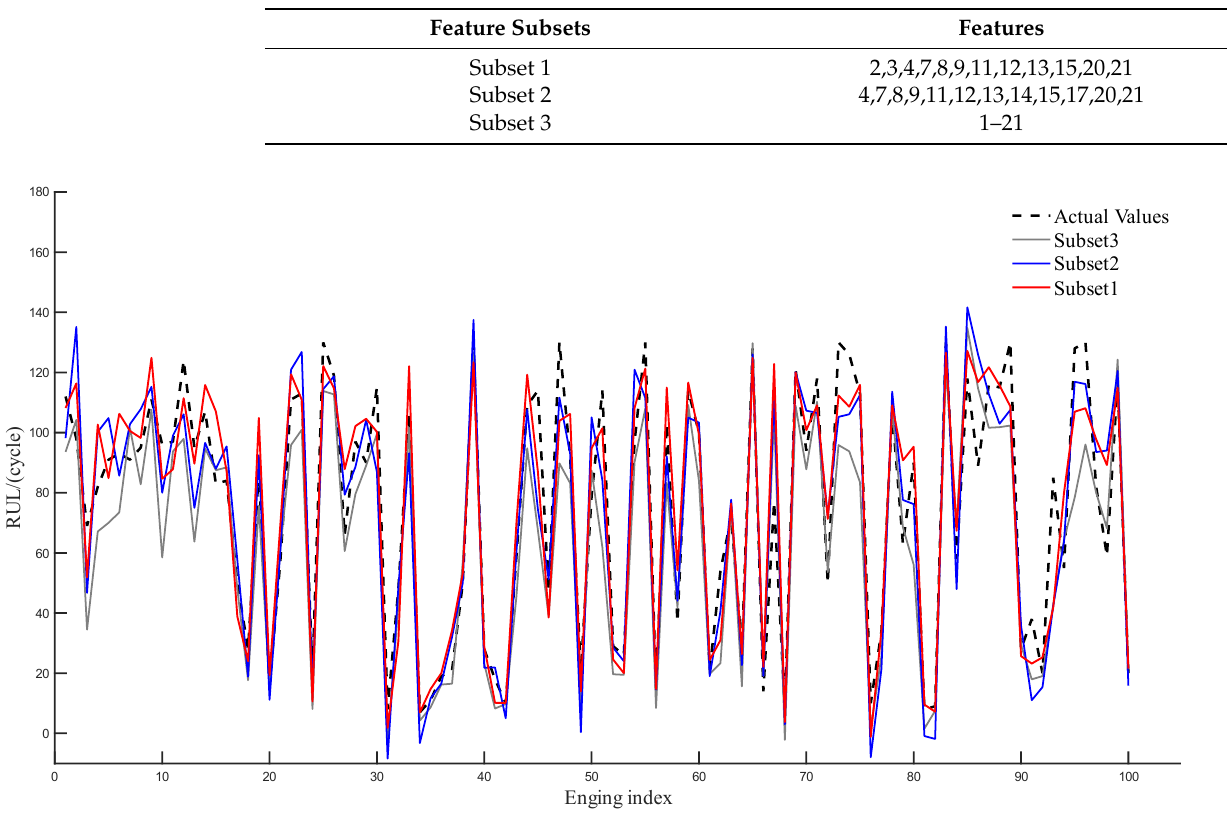
Table 11. Evaluation indexes for different feature subsets.